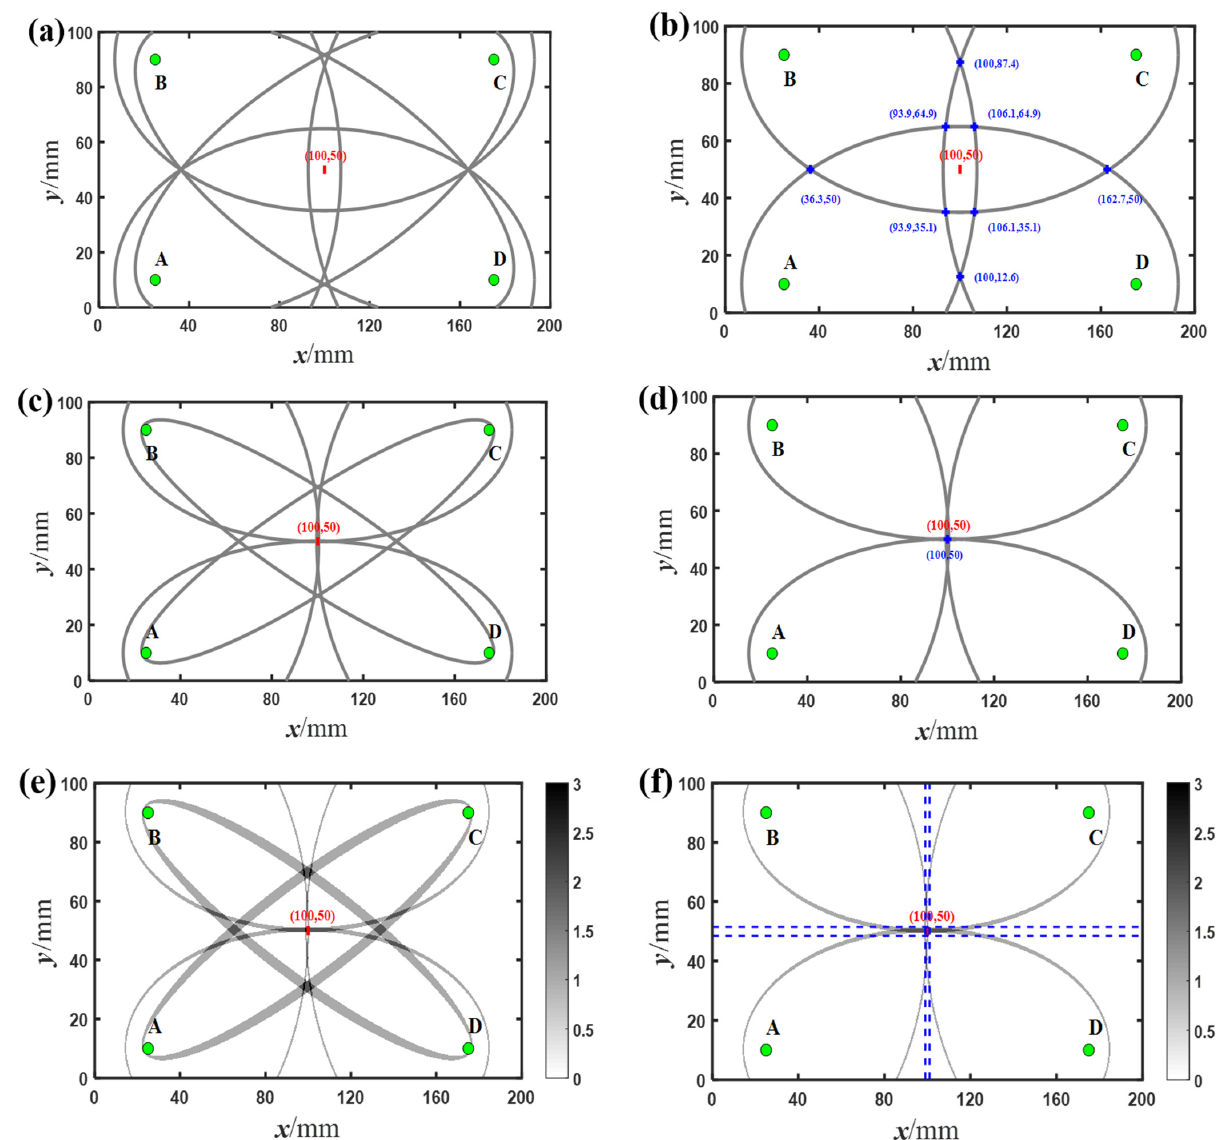
Figure 12. Simulated localization and imaging of the breathing crack (( a ) red line) with ellipse method using linear Lamb waves ( a , b ) and nonlinear Lamb waves ( c , d ), and with modified ellipse method using nonlinear Lamb waves ( e , f ). ( a , c , e ): signals received from all sensing paths were taken. ( b , d , f ): signals received from all sensing paths but AC and BD were taken.